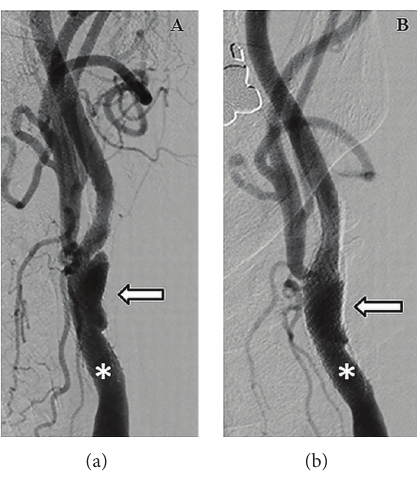
Figure 1: (a) Angiogram of the left carotid artery (asterisk) showing the ulcerated plaque at the stent site resulting in 70% stenosis (arrow). (b) Angiogram of the left carotid artery (asterisk) after the placement of a self-expanding Acculink 7 × 10 × 40mm stent